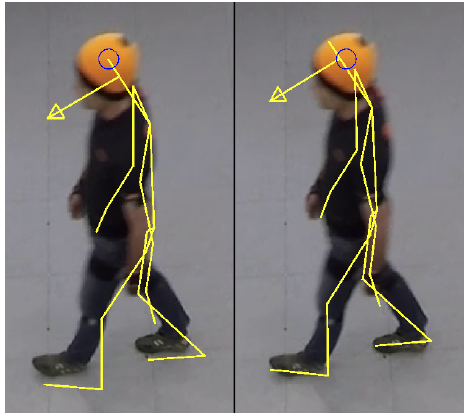
Figure 6. Snapshot of the person within the experiment from a slanted view and a projected line- based yellow overlay of the skeleton coming from the IMU system (arrow points in the direction of the head orientation). ( Left ) Center of gravity of the colored blob of the worn orange cap (center of blue circle) is chosen for the absolute position of the person’s head coming from the camera system. ( Right ) Position of the top of the head coming from the camera system is chosen according the underlying biomechanical model of the IMU system, which leads to a better fusion